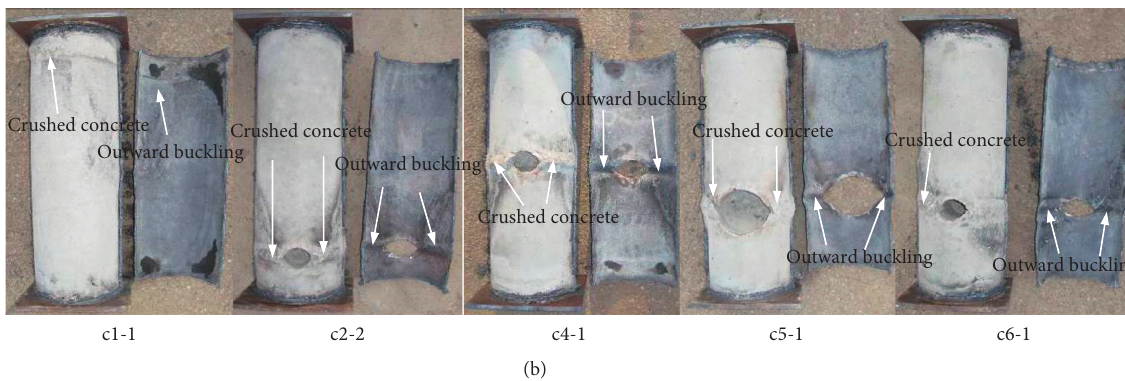
Figure 4: Typical failure modes of the concrete core. (a) Square section. (b) Circular